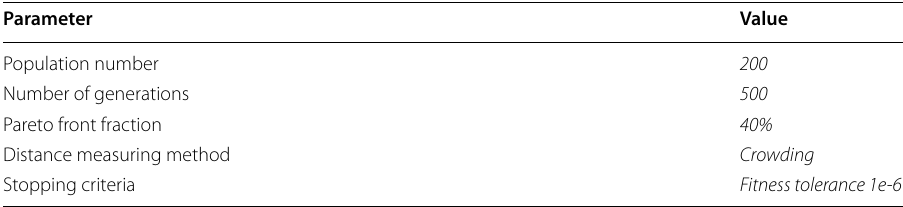
Table 6 Optimization algorithm parameters Parameter